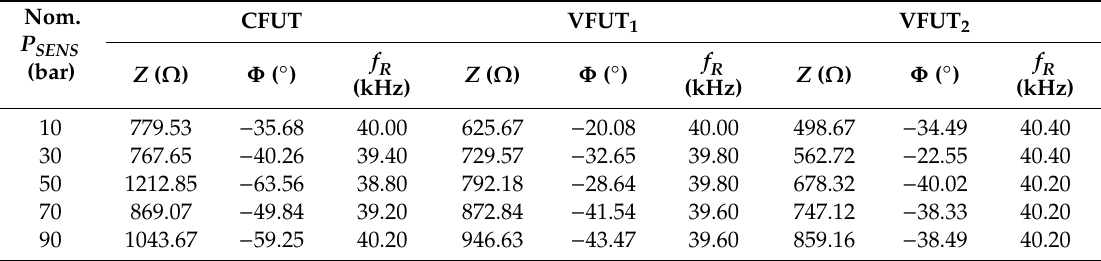
Figure 6. Electrical spectra of the transducers at di ff erent air pressure levels ( ± 0.5 bar) showing: ( a ) Z -Frequency (CFUT); ( b ) Z -Frequency (VFUT 1 ); ( c ) Z -Frequency (VFUT 2 ); ( d ) Φ -Frequency (CFUT); ( e ) Φ -Frequency (VFUT 1 ); ( f ) Φ -Frequency (VFUT 2 ). Table 1. Magnitudes of Z , Φ , and f R at di ff erent air pressure levels measured through electrical impedance analysis, where specific pressure levels can be correlated with the associated magnitudes shown in Figure 6.